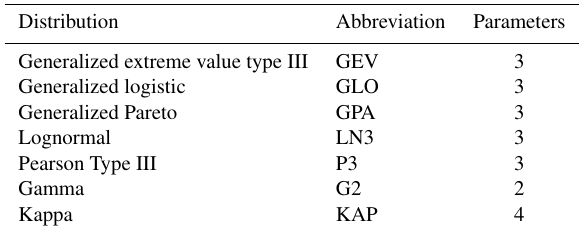
Table 4. Distributions used in probability plot goodness-of-fit eval-